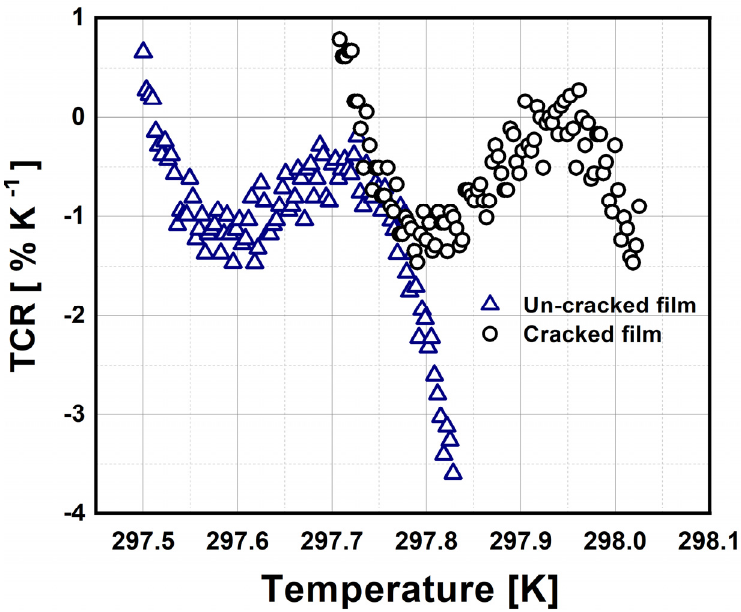
Figure 6. TCR for uncracked and cracked films of SWCNT. Table 2. Thermo–electrical parameters for uncracked and cracked films of